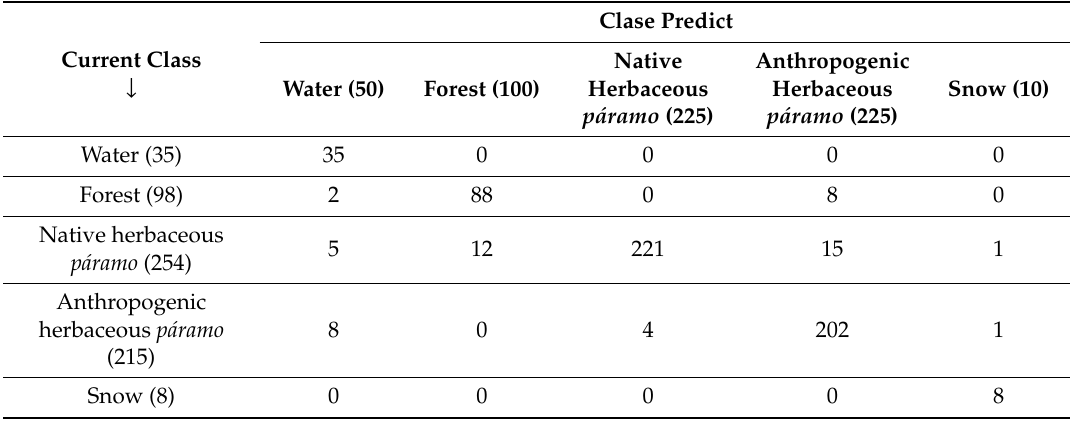
Table 2. The resulting confusion matrix from the validation process in the study area.